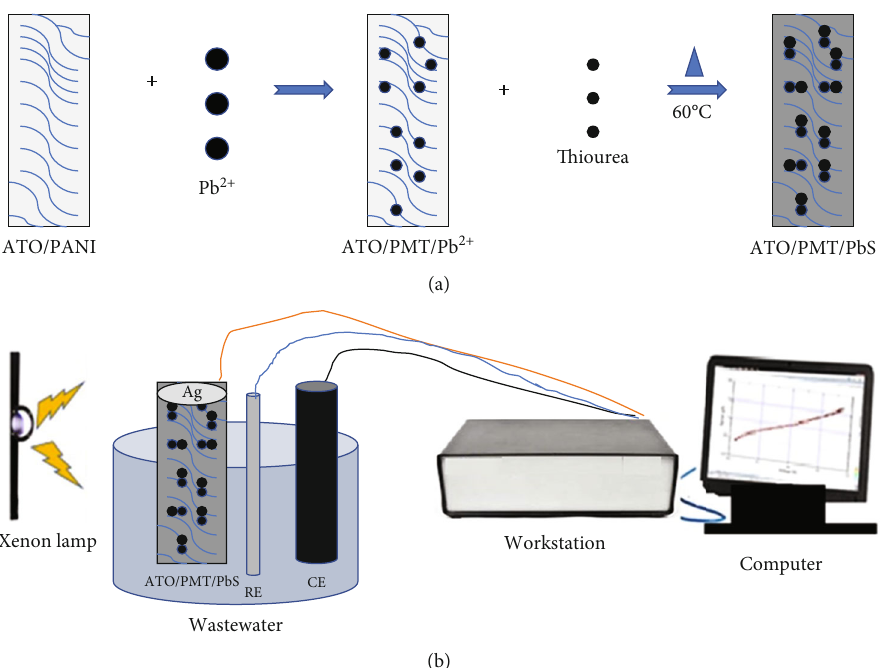
Figure 1: (a) The schematic deposition of PbS on ATO/PANI and (b) the three-electrode cell for electrochemical H